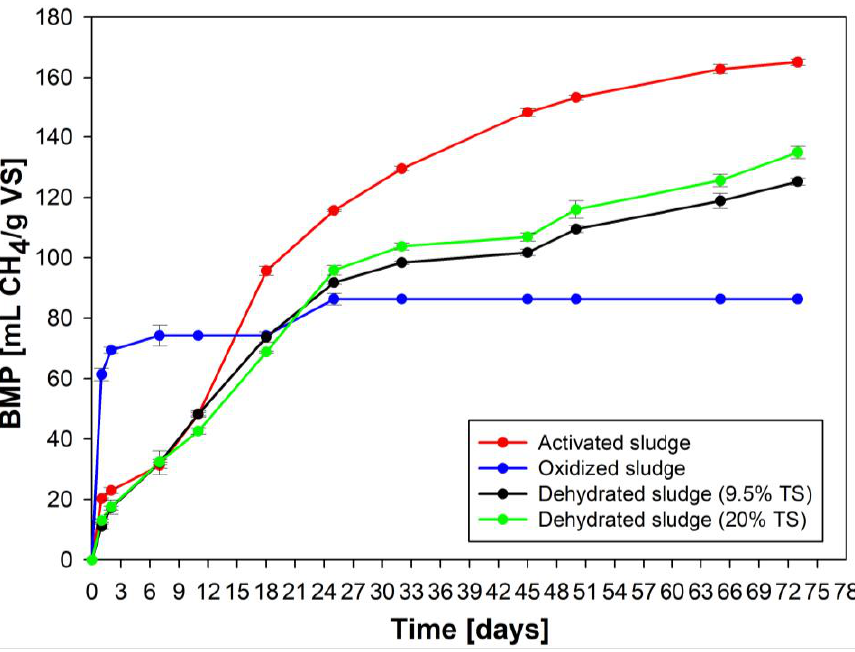
Figure 1. Cumulative biomethane profiles of activated, dehydrated and oxidized, sewage sludge obtained over 74 days of anaerobic digestion. Values and error bars represent the averages and standard deviations of triplicates for each experimental condition, respectively. TS = total solids.